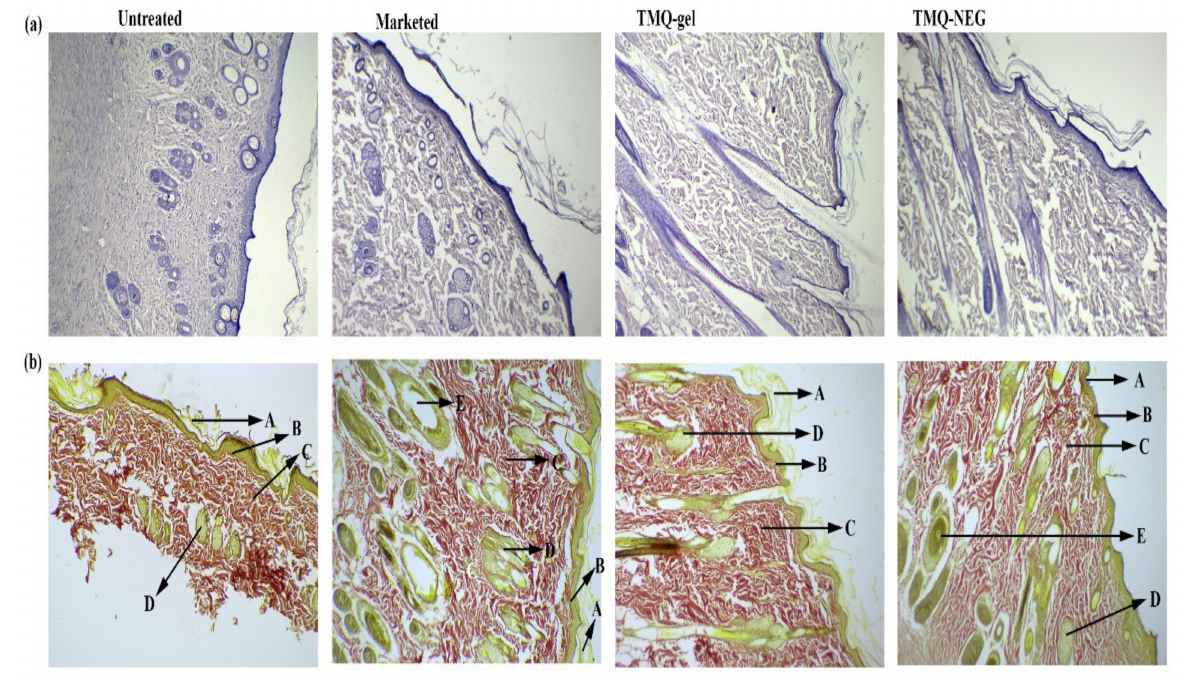
Figure 6. Histopathology analysis of newly healed tissue at day 20 ( a ) stained with hematoxylin-eosin ( b ) stained with Van Gieson to observe collagen formation (at 10 × magnification). A—stratum corneum; B—papillary dermis; C—collagen fibers; D—sebaceous gland; E—hair